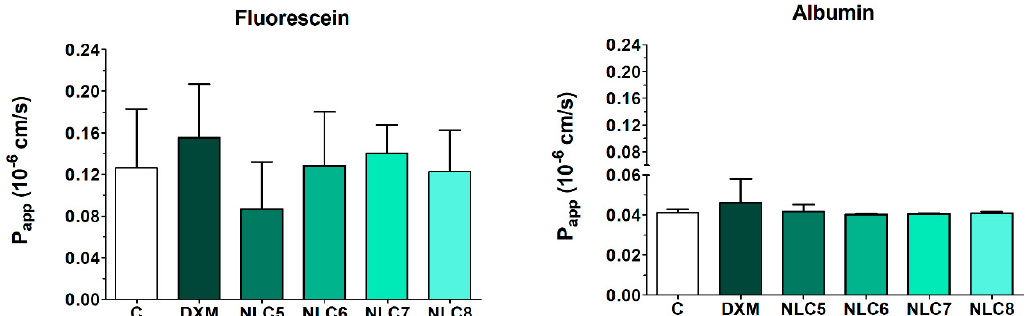
Figure 12. Apparent permeability coefficients (P app ) of passive paracellular permeability markers fluorescein and Evans blue labeled albumin measured on HCE-T corneal epithelial cell layers. Values are presented as means ± SD, n = 4. Statistical analysis: ANOVA followed by Dunnett’s test.